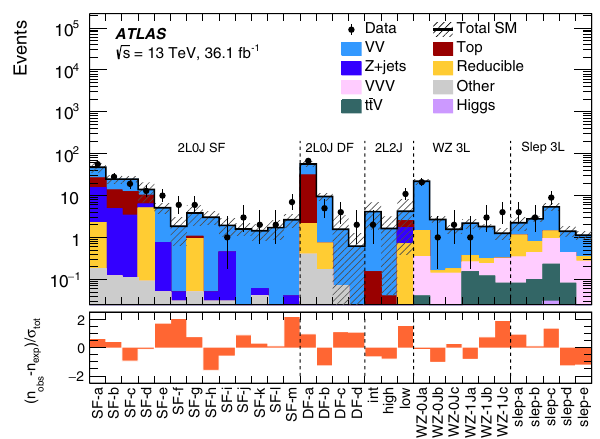
Fig. 3 The observed and expected SM background yields in the sig- nal regions considered in the 2 (cid:4) + 0 jets, 2 (cid:4) + jets and 3 (cid:4) channels. The statistical uncertainties in the background prediction are included in the uncertainty band, together with the experimental and theoretical uncertainties. The bottom plot shows the difference in standard devi- ations between the observed and expected yields. Here n obs and n exp are the observed data and expected background yields,